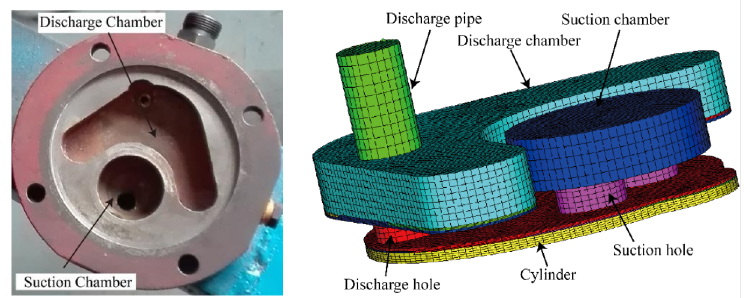
Figure 3. The fluid domain of the compressor in the FSI